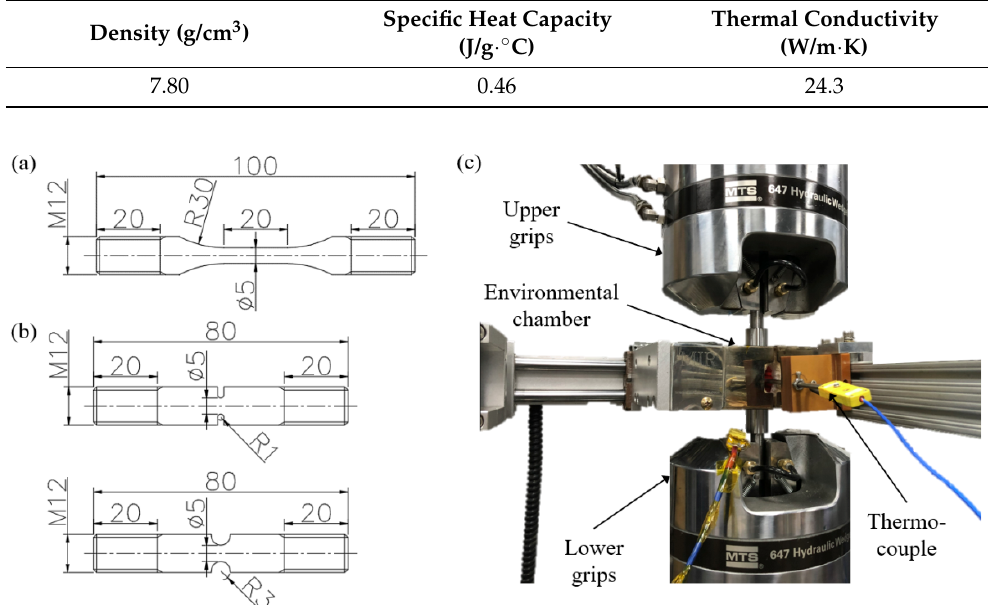
Table 2. The physical and thermal properties of AISI H13 hot work tool steel.